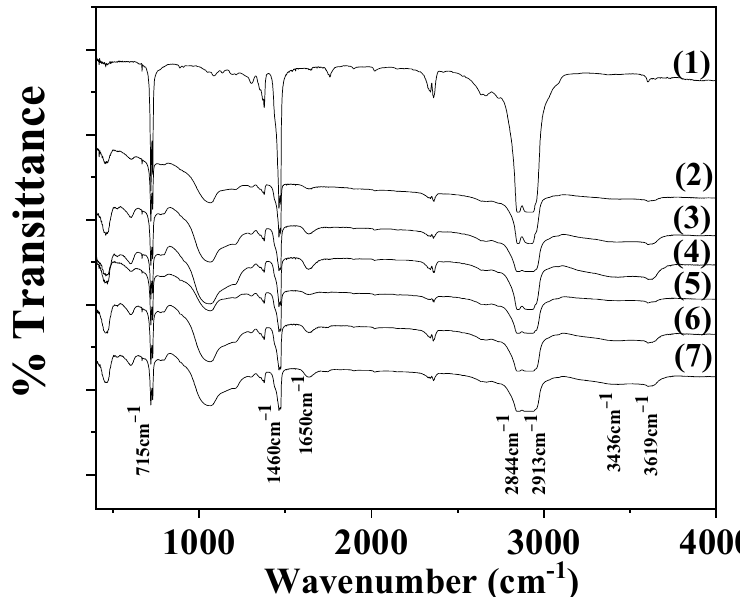
Figure 3. FTIR plots of (1) pure LDPE, (2) LDPE/5NZ, (3) LDPE/10NZ, (4) LDPE/15NZ, (5) LDPE/5TO@NZ, (6) LDPE/5TO@NZ, and (7) LDPE/5TO@NZ films. In the FTIR plots of both LDPE/xNZ and LDPE/xTO@NZ films, as well as for the pure LDPE films, the characteristic peaks of LDPE and NZ are mainly observed [13,25]. More specifically, at 1460 and 715 cm − 1 , asymmetric stretching of CH 3 group, wagging of the CH 2 group, and rocking of CH 2 group are observed in LDPE. At 2913 and 2844 cm − 1 , 3619 and 3436 cm − 1 are assigned to the OH group stretching mode of NZ. The band at 1650